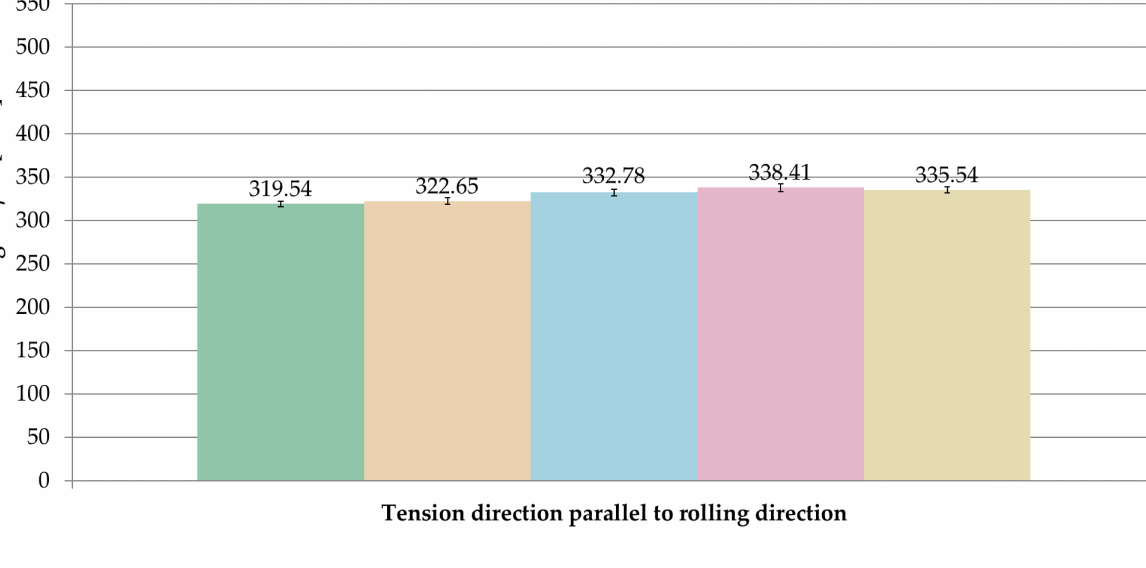
Figure 13. Comparison of yield strength R p 0.2 for samples stretched parallel to the rolling